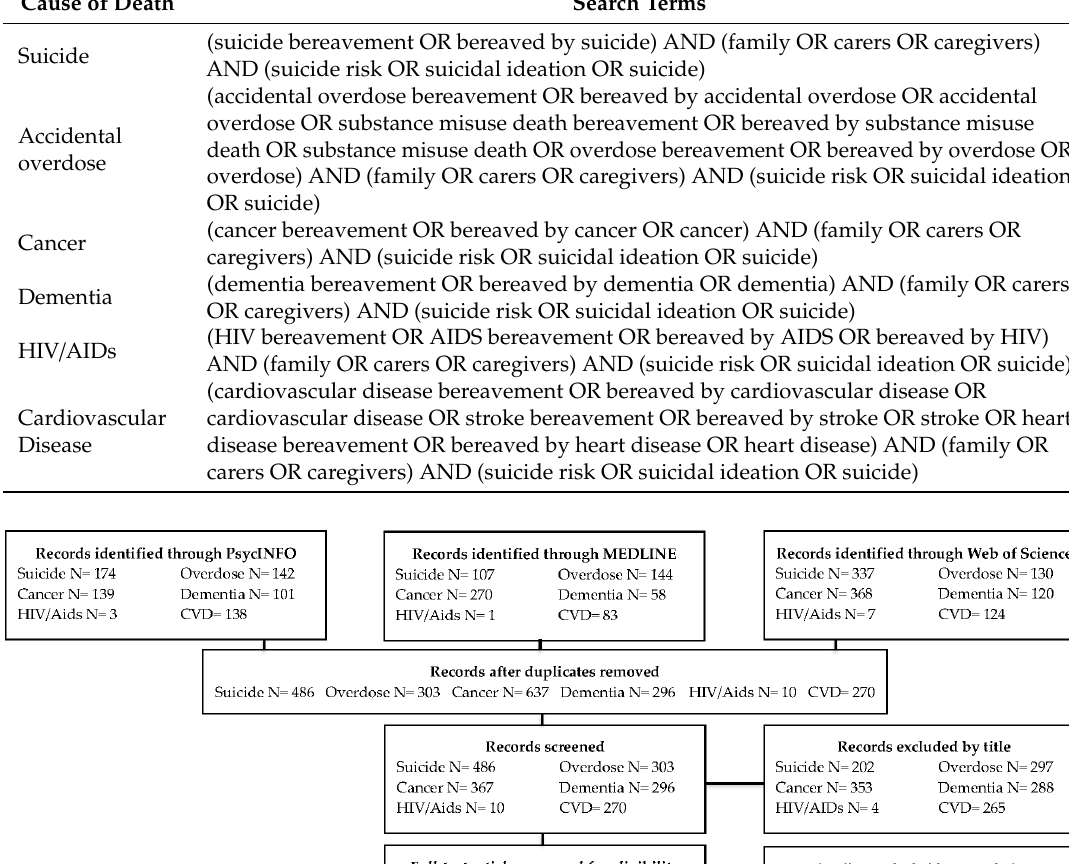
Table 1. Search strategy by bereavement group.